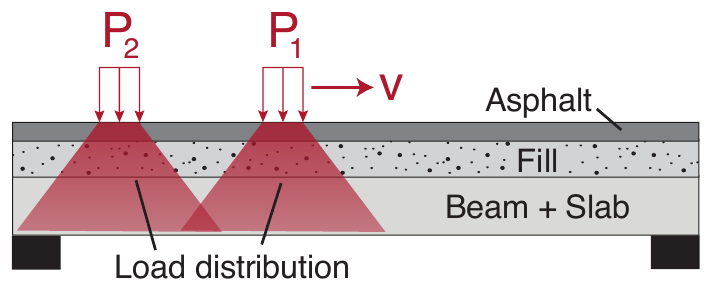
Figure 8. Sketch of vehicle load distribution through a bridge